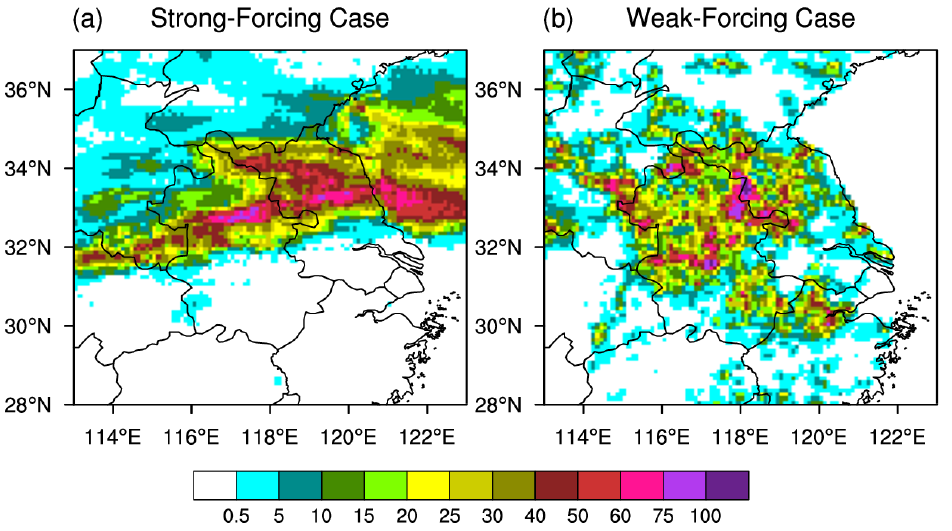
Figure 2. The spatial distributions of 12-h accumulated precipitation in ( a ) the SF case and ( b ) the WF case.